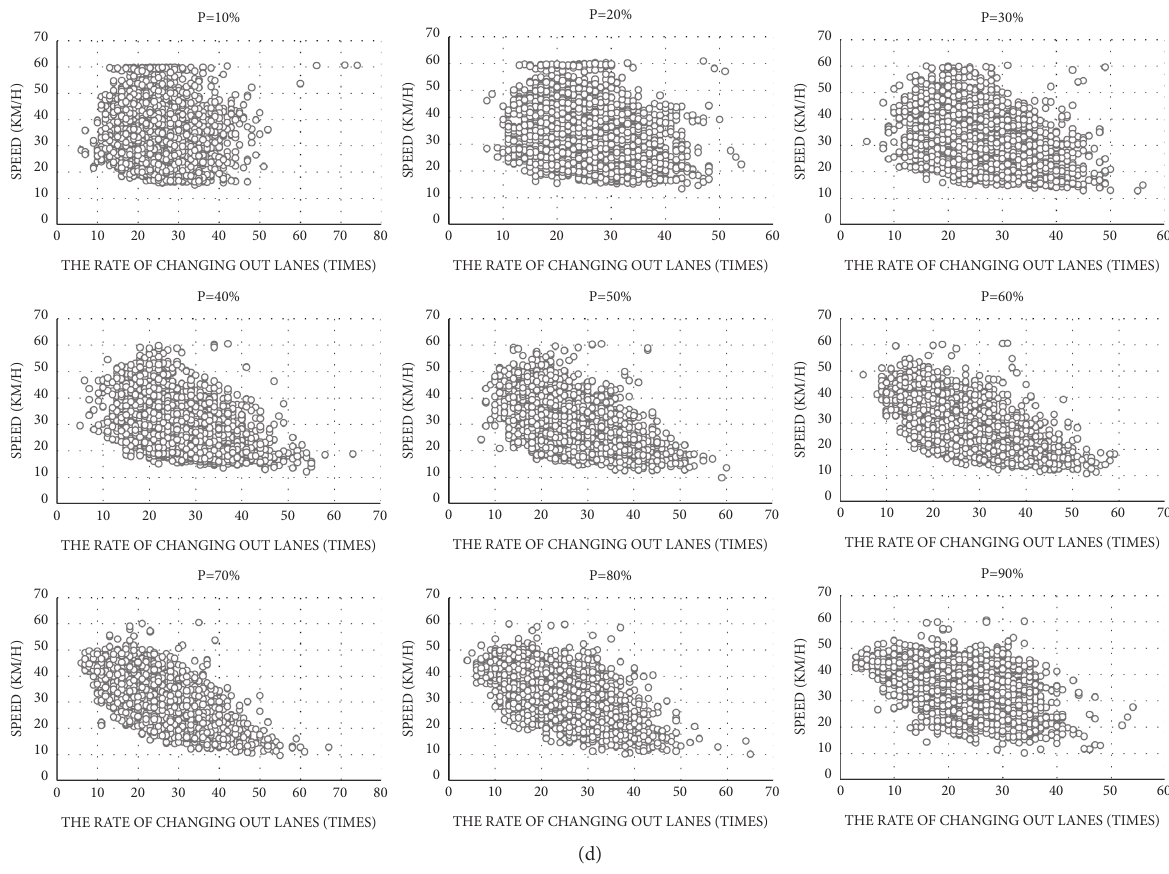
Figure 8: Scatter plot of the relationship between speed and the rate of changing out of lanes. (a) A scatter plot of Lane 1. (b) A scatter plot